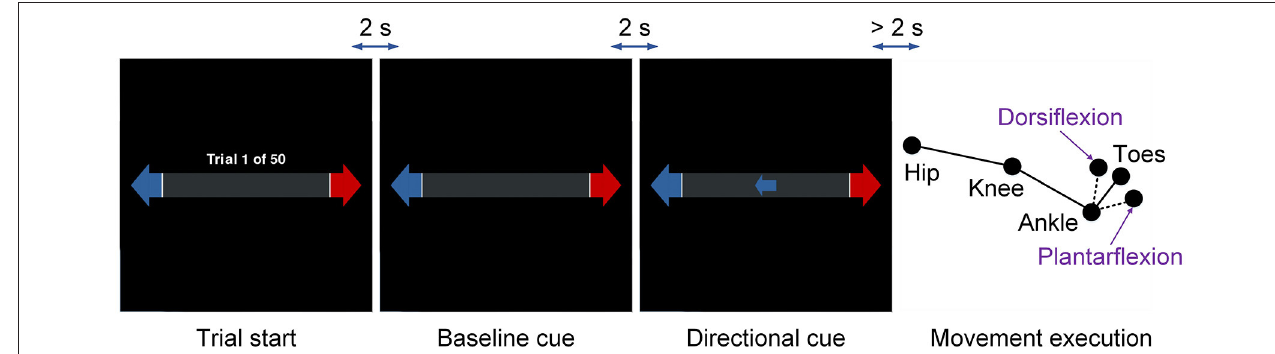
FIGURE 1 | Protocol of the experiment. The movement type refers to ankle dorsiflexion and plantar flexion, and the limb side refers to left and right legs. The movement type was consistent within each run and the limb side was indicated by the directional